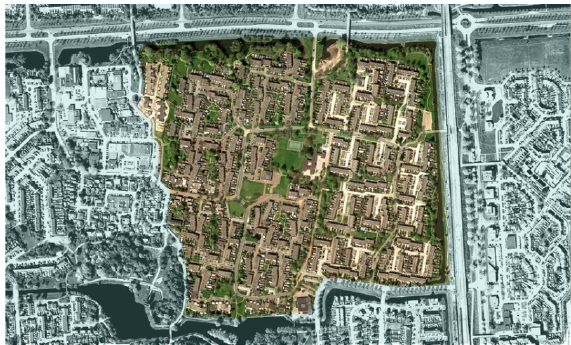
Figure 13. Kempenaar: aerial map. Source: authors.